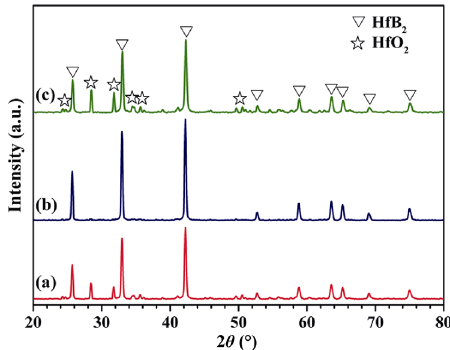
Fig. 1 XRD patterns of the as-synthesized products at different conditions: (a) 1273 K with molten salts, (b) 1373 K with molten salts, and (c) 1373 K without molten salts.